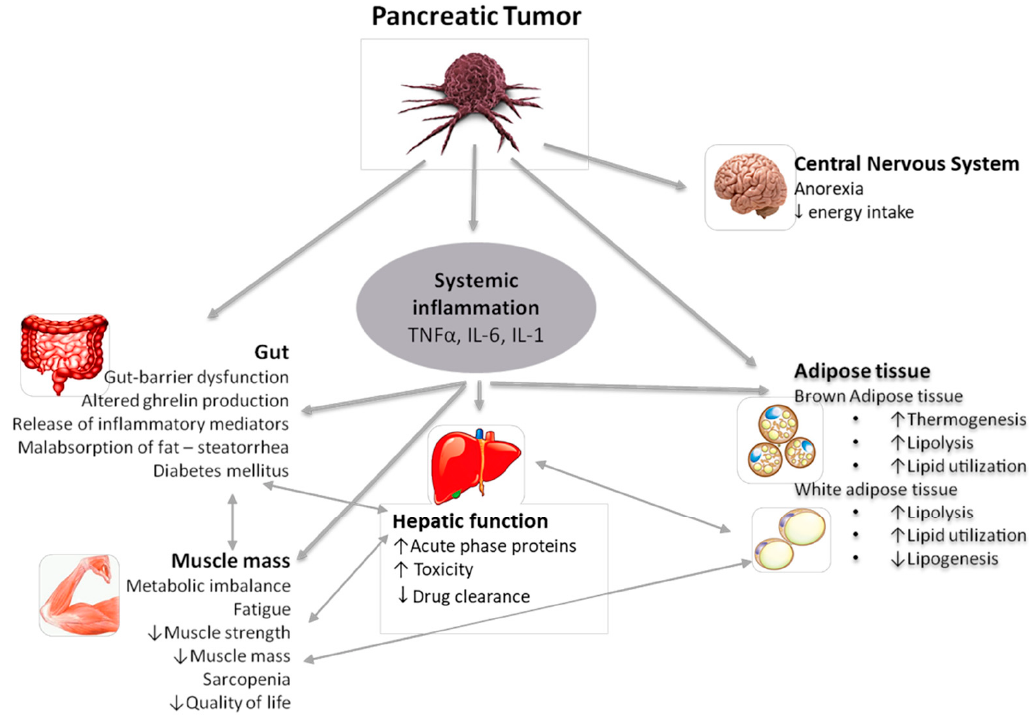
Figure 1. Pathophysiology of Pancreatic Cachexia: Organs, molecules, and metabolic dysregulations. TNF- α : tumor necrosis factor α ; IL: interleukin.